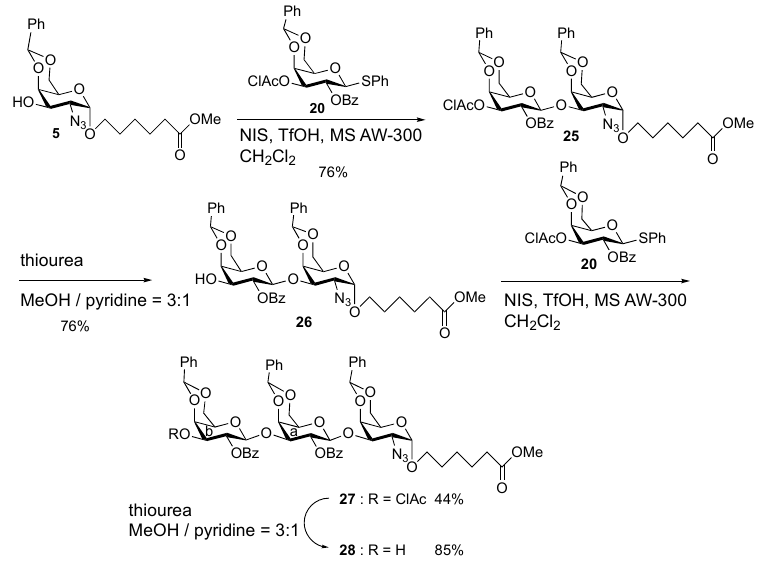
Scheme 5. Preparation of trisaccharide derivatives.